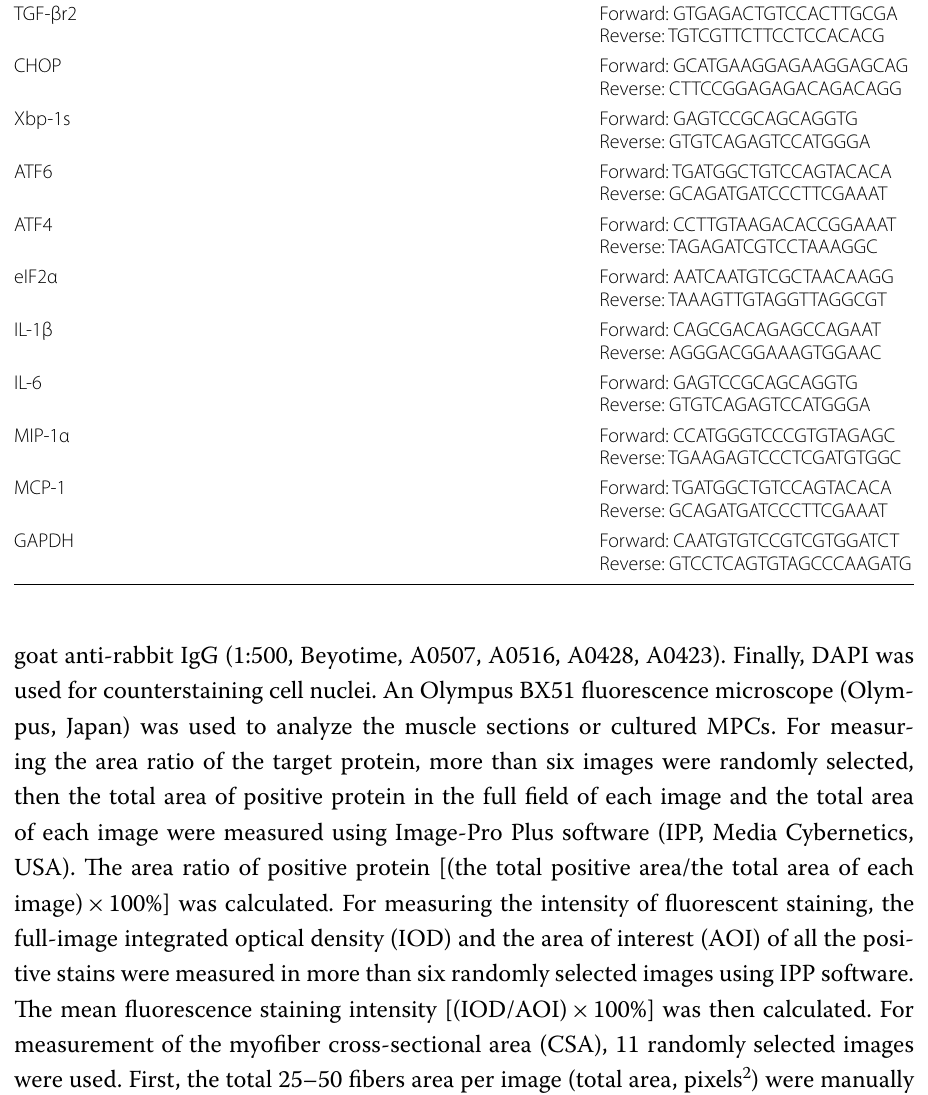
Table 1 Primer sequences used for PCR Genes Sequences (5 ′ –3 ′ )